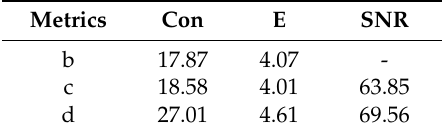
Table 1. Evaluation of the hydrophobic images after pretreatment.